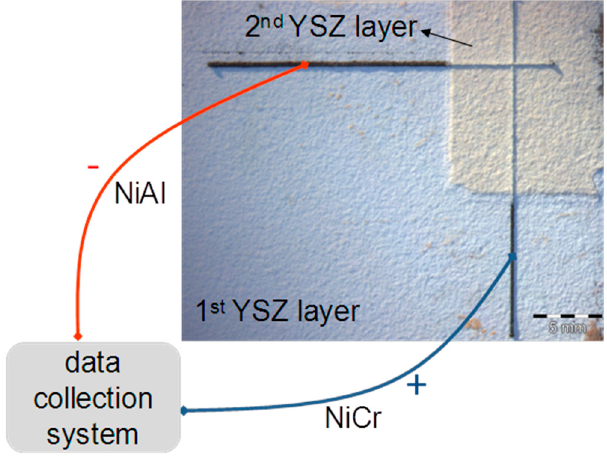
Figure 2. A photo of an embedded thermocouple and a set-up for collecting temperature signals. Parameters of laser cladding have been chosen according to optimized microstructures as discussed in Subsection 3.2.